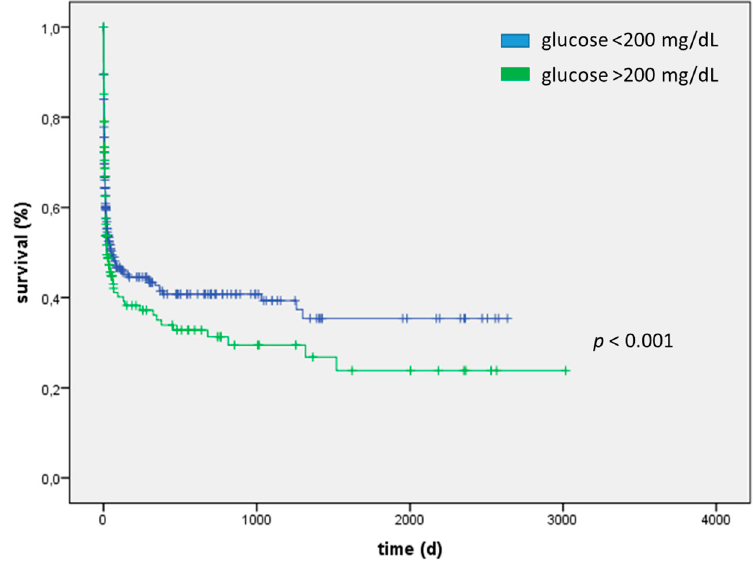
Figure 3. Myocardial infarction patients with severe hyperglycemia at admission day evidenced a significantly increased mortality in the long-term (HR 2.19, 95% CI: 1.66–2.89; p < 0.001). Table 6. In patients suffering from AMI and severe hyperglycemia (>200 mg/dL) were sicker (SAPS2 score 41 ± 16 vs. 32 ± 16; p < 0.001) and older (73 (65–79) vs. 68 (57–77) years; p < 0.001).